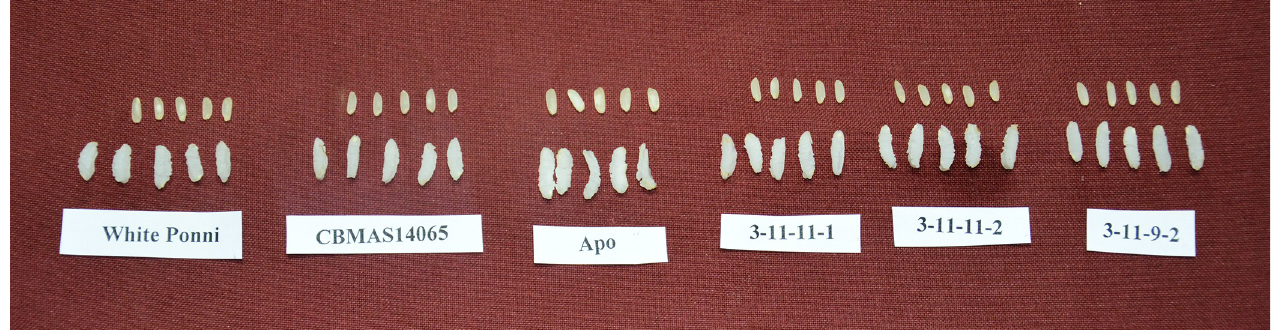
Fig 10. Cooking quality characteristics of BILs, CBMAS14065 and IWP.